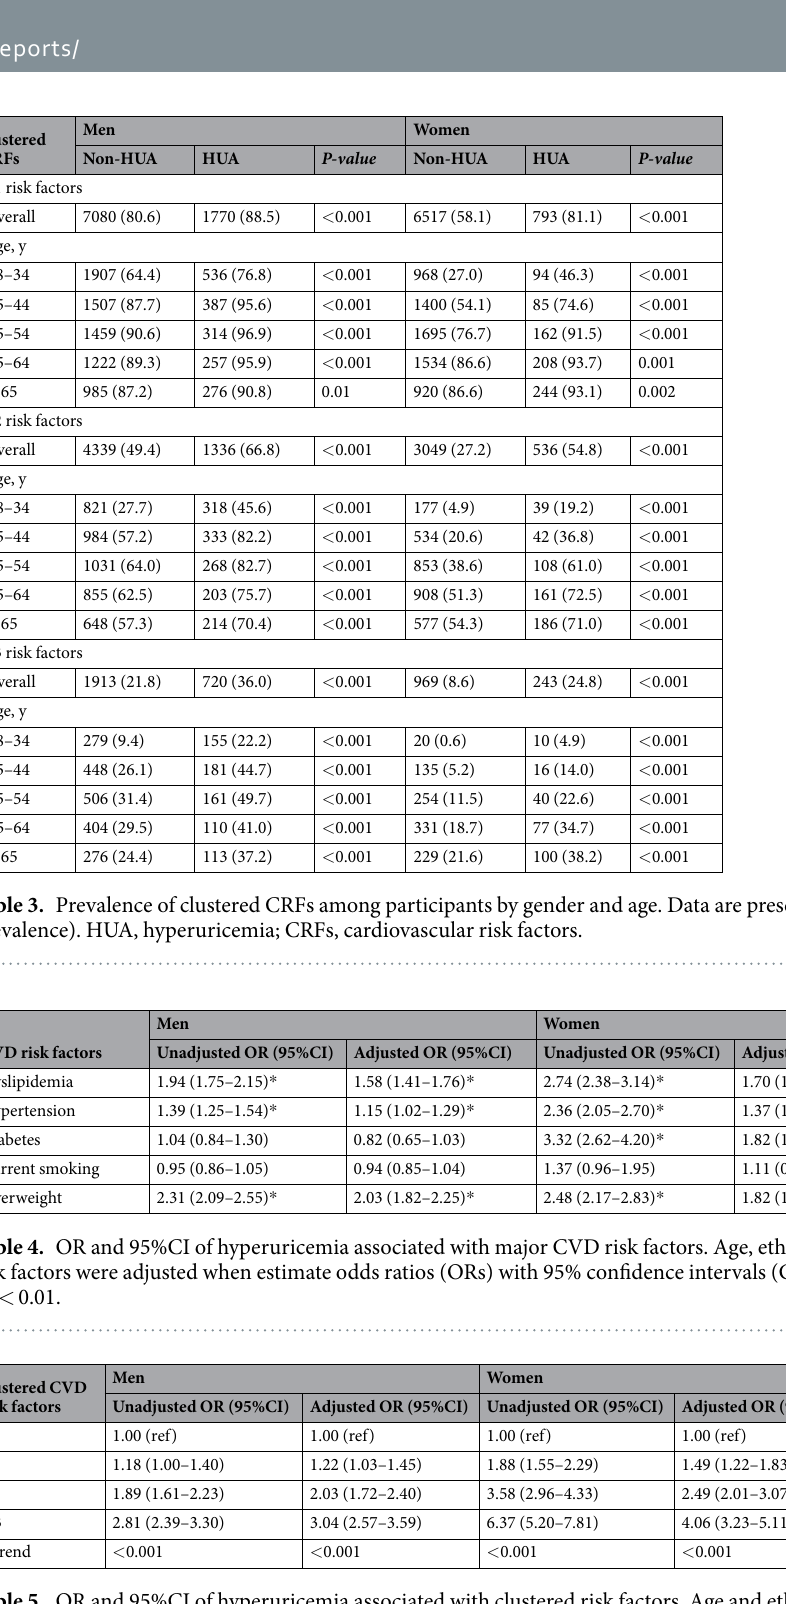
Table 5. OR and 95%CI of hyperuricemia associated with clustered risk factors. Age and ethnicity were adjusted when estimate odds ratios (ORs) with 95% confidence intervals